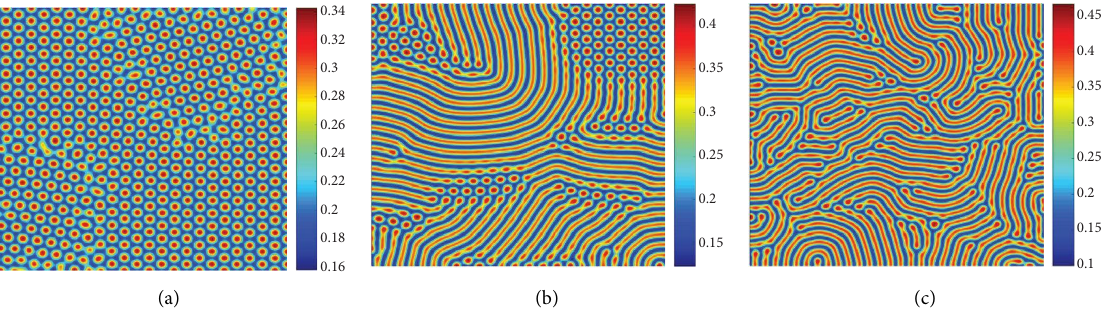
Figure 2: Pattern selection when q � 0 . 6: (a) μ